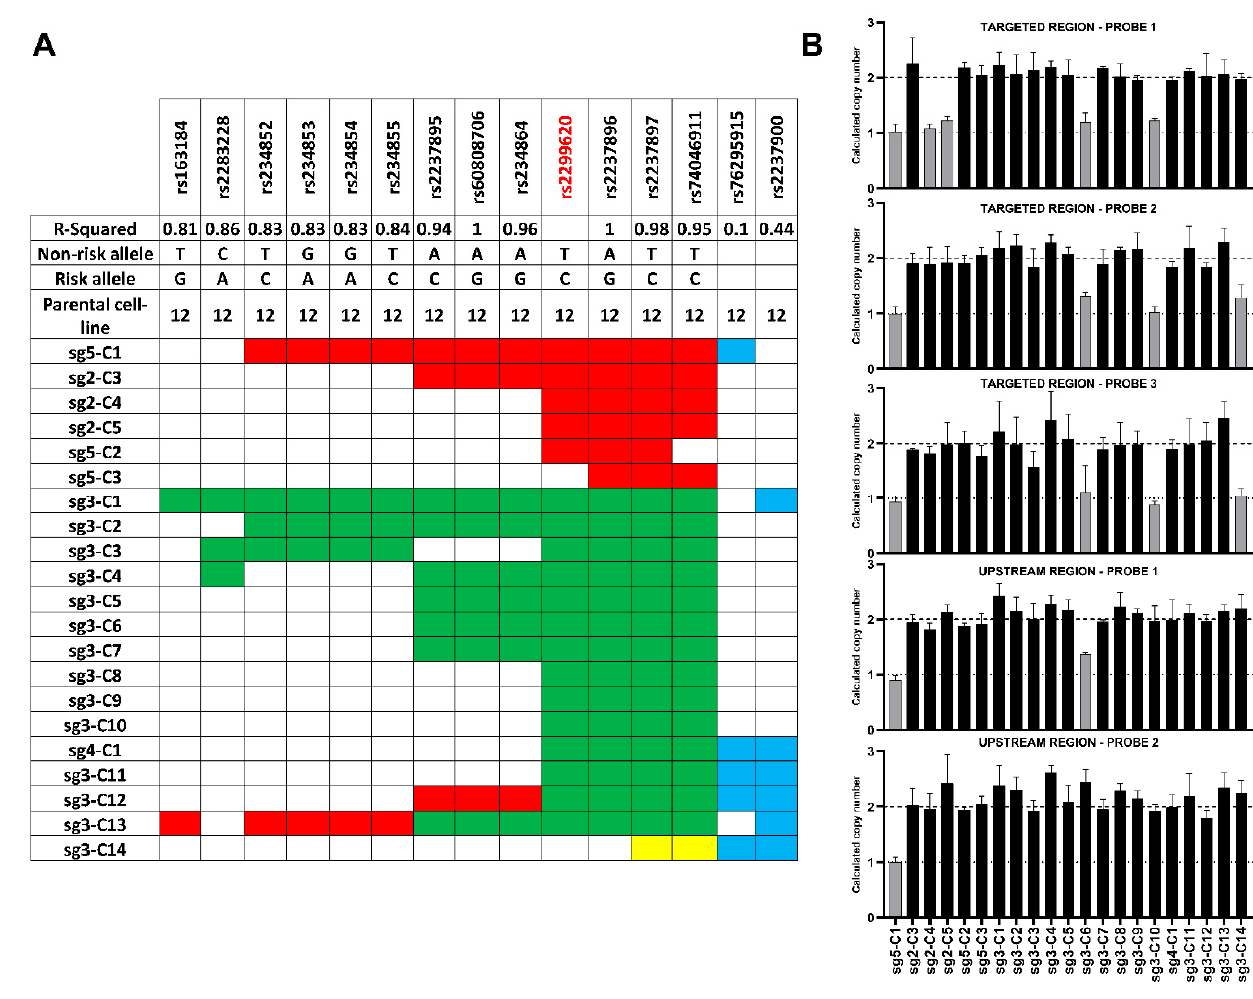
Figure 3. Extended genotyping of the clonal cell lines and identification of CRISPR induced large deletions. ( A ). Extended genotyping of the established clonal cell lines by sequencing to identify stretch of homozygosity. Parental cell line was heterozygous (12) for all of the SNPs. Red—homozygous for risk allele, green—homozygous for the non-risk allele, no fill—heterozygous (no edit), blue—homozygosity outside the LD block, yellow—deletion. The lead SNP is indicated in red. ( B ). CNV assay for identification of large deletions. Results of CNV assay using multiple probes in clonal cell lines. Results from the parental cell line was used as the calibrator for analysis. Y-axes represent the calculated copy number. Grey bars indicate a copy number of 1 suggestive of a hemizygous deletion. Assays were done in triplicate and the error bars indicate calculated copy number range.